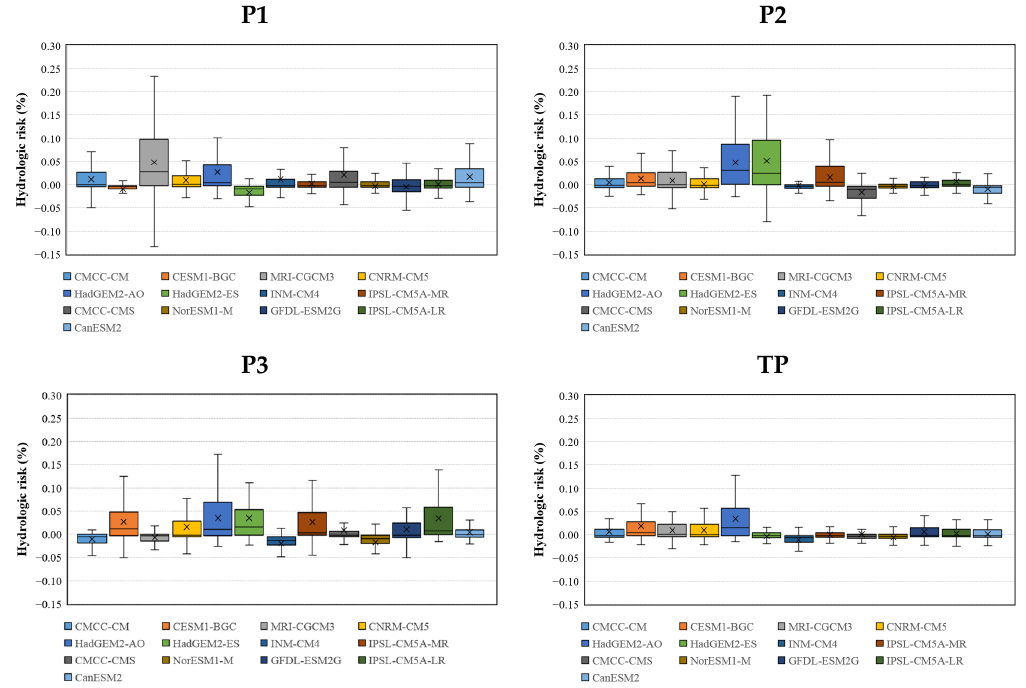
Figure 6. Box plots of hydrologic risks of the 100-year flood according to the RCP 4.5. P1